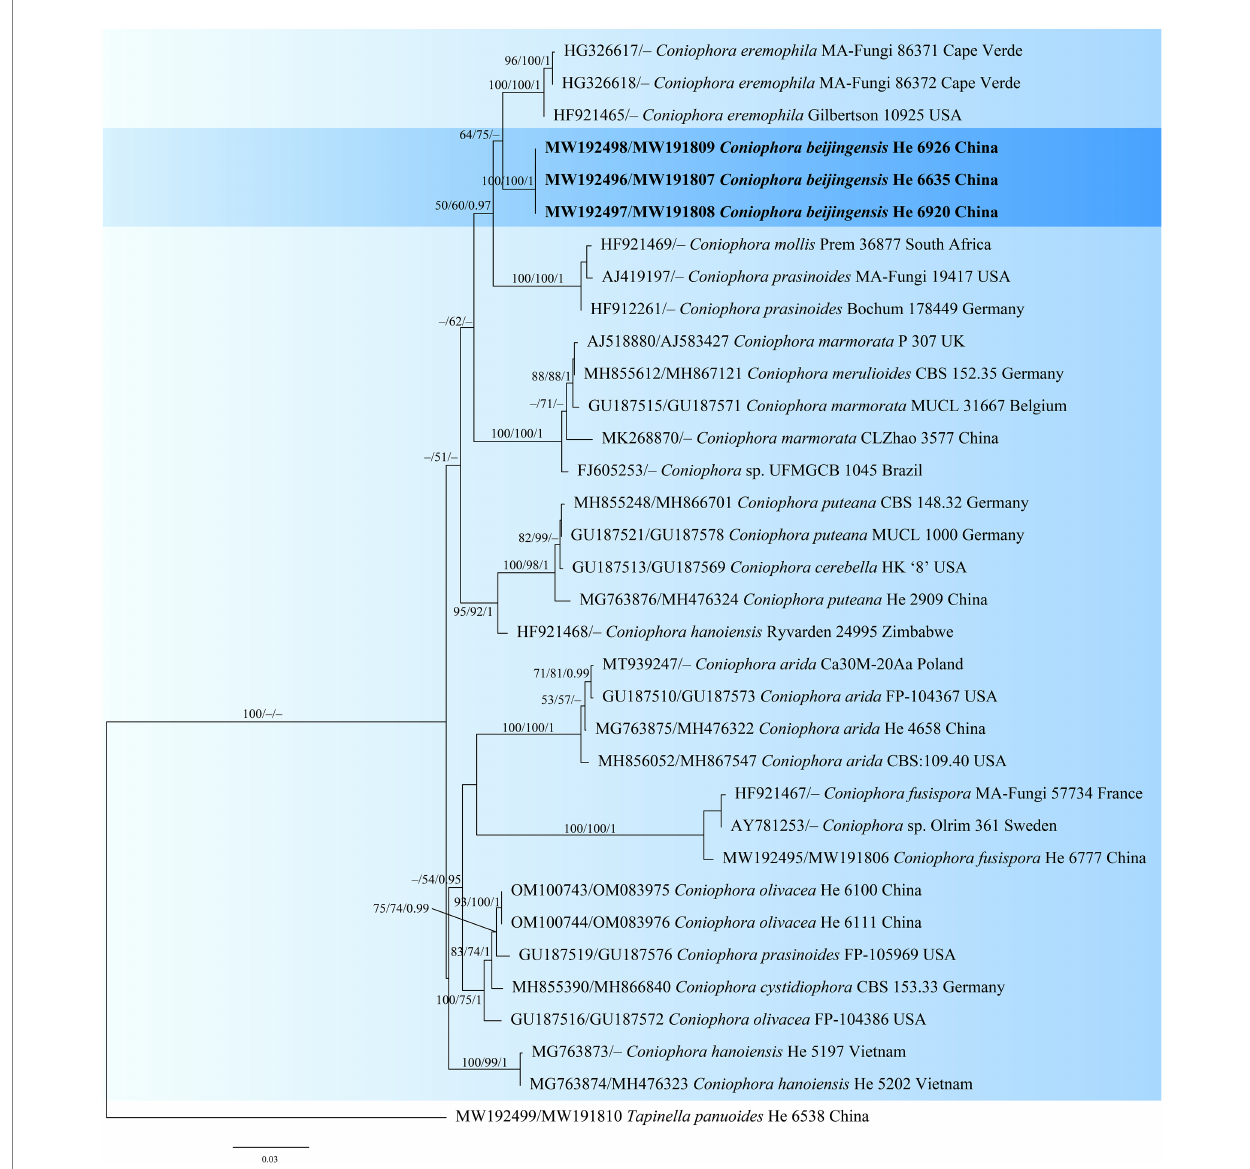
FIGURE 1 Phylogenetic tree obtained from ML analysis of the ITS-28S sequences of Coniophora . Branches are labelled with parsimony bootstrap values ( ≥ 50%, first), likelihood bootstrap values ( ≥ 50%, second) and Bayesian posterior probabilities ( ≥ 0.95, third). New species are set in bold and